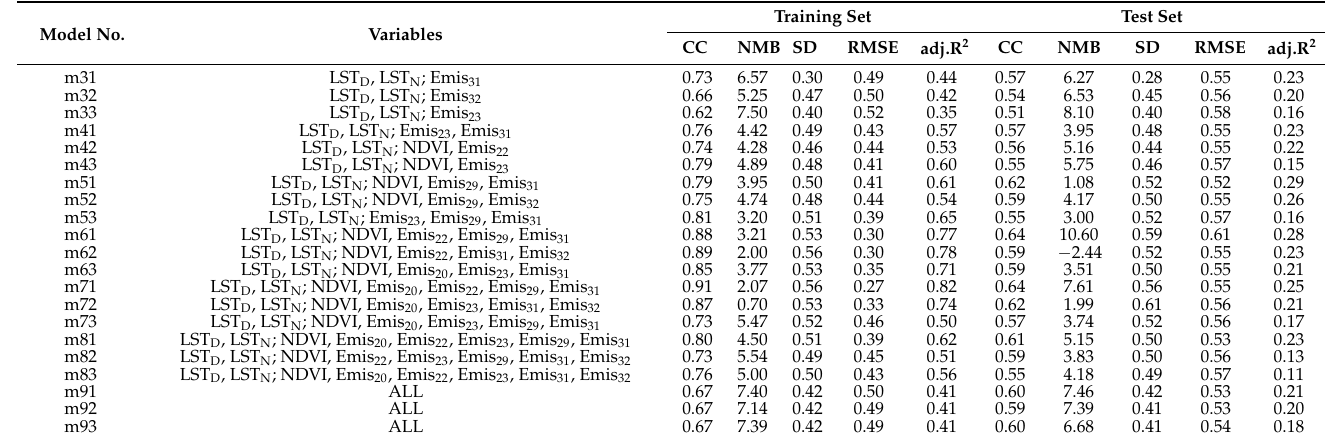
Table 3. The performance with the best combinations of different numbers of input variables under the five-fold cross validation.